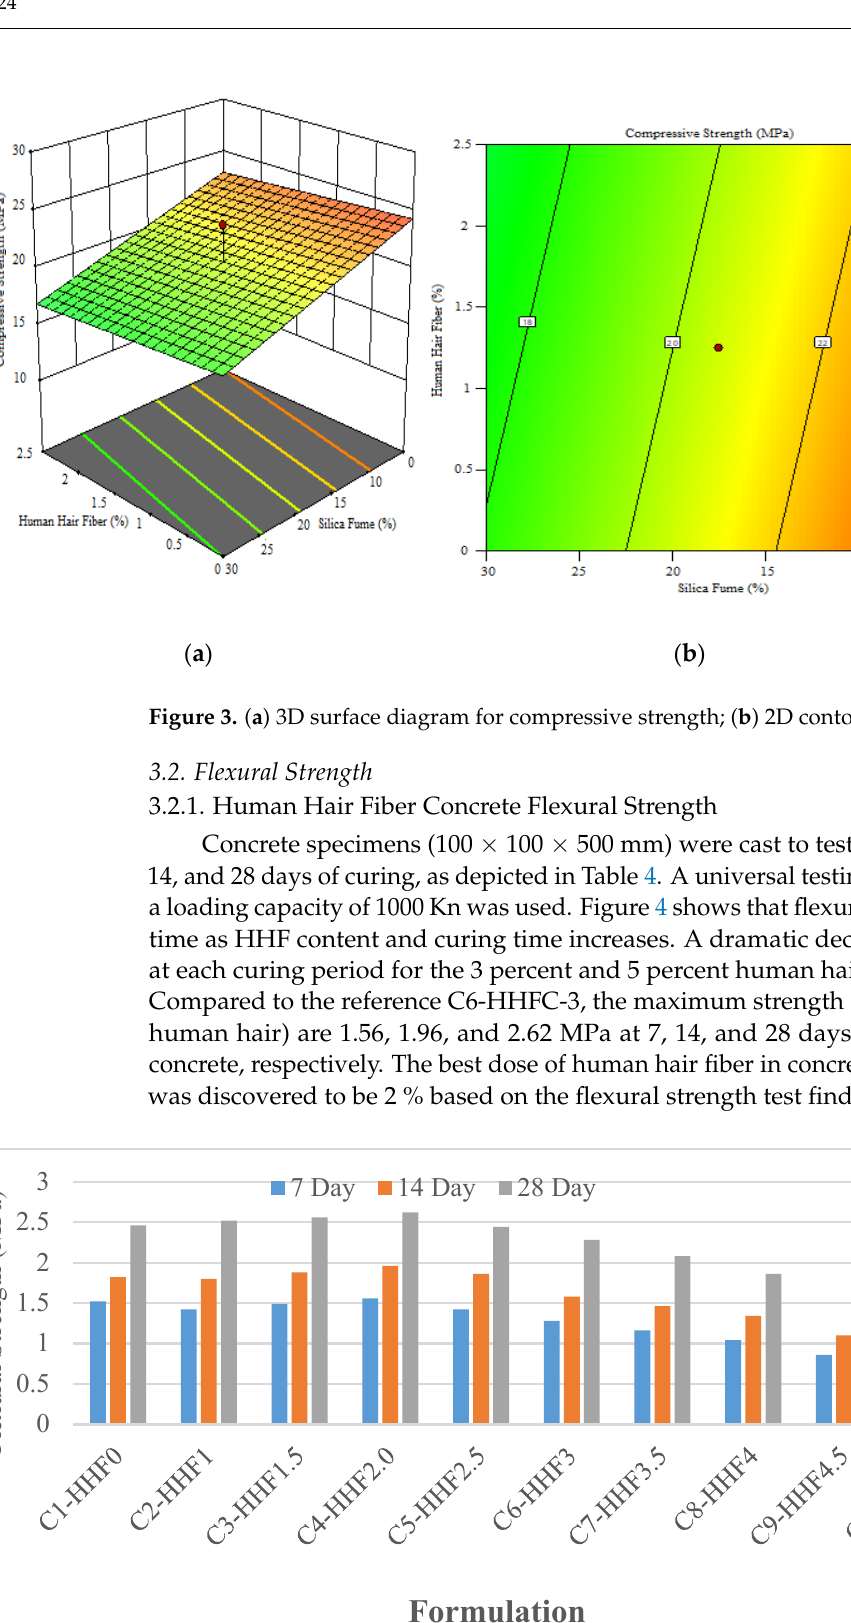
7 of 16 Figure 2. Compressive strength of concrete human hair fiber with Silica fume. 3.1.3. Effect on HHFC Compressive Strength with Replacement of Cement by Silica Fume Using RSM The red zone represents a higher strength region, whereas the green region repre ‐ sents a lower strength region of HHFC strength, as shown in the 2D contour plot in Figure